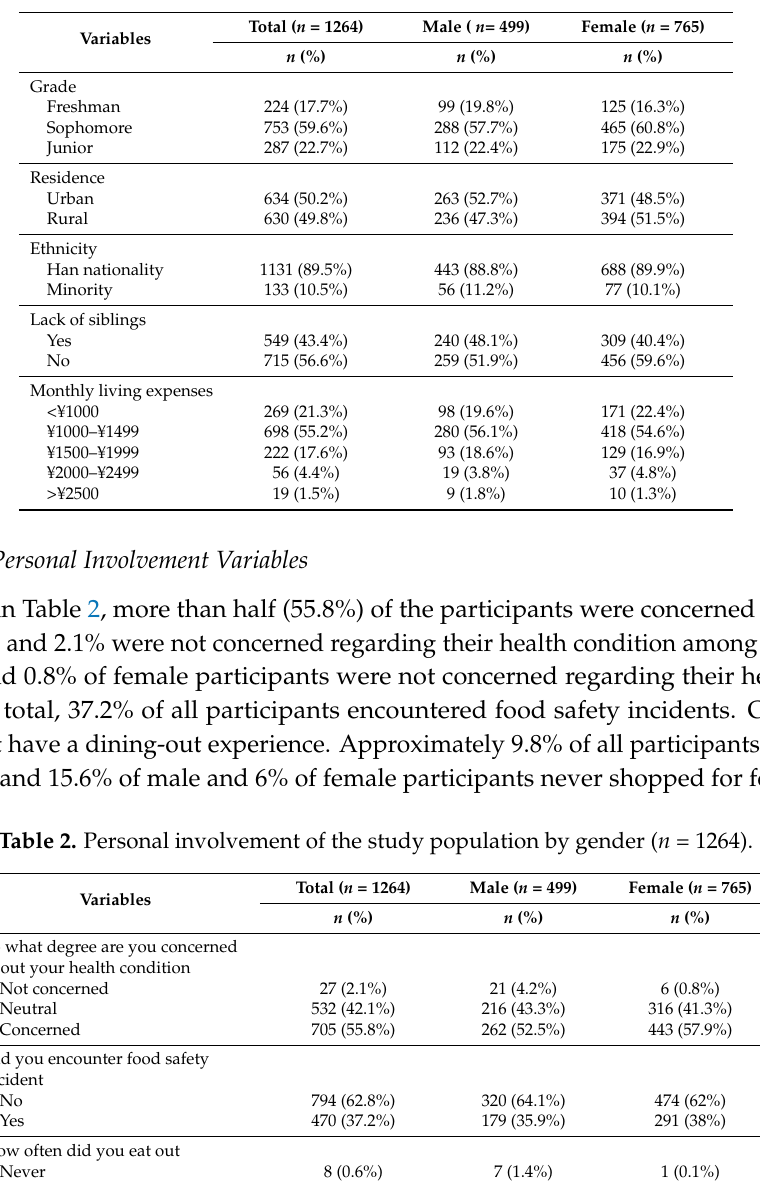
Table 1. Demographic characteristics of the study population by gender ( n = 1264).